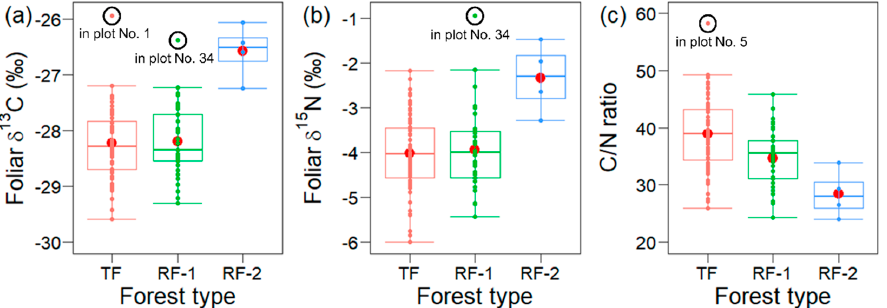
Figure 5. Box plots of the ( a ) δ 13 C (‰), ( b ) δ 15 N (‰), and ( c ) C/N ratio of each tree sample from the TF ( n = 68), RF-1 ( n = 33), and RF-2 ( n = 4). Box encompasses the 25th through 75th percentiles (inter-quartile range IQR) with the median 50%. Lower (higher) whisker corresponds to the smallest (largest) observation within 1.5 times IQR below the lower quartile (above the upper quartile). Boxplot outliers are circled with the plot number. Red dot in a box indicates mean value of all samples from a forest type.